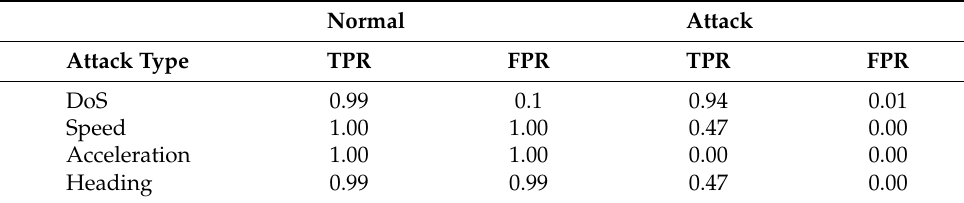
Table 9. In-depth evaluation of the Decision Stump Algorithm.